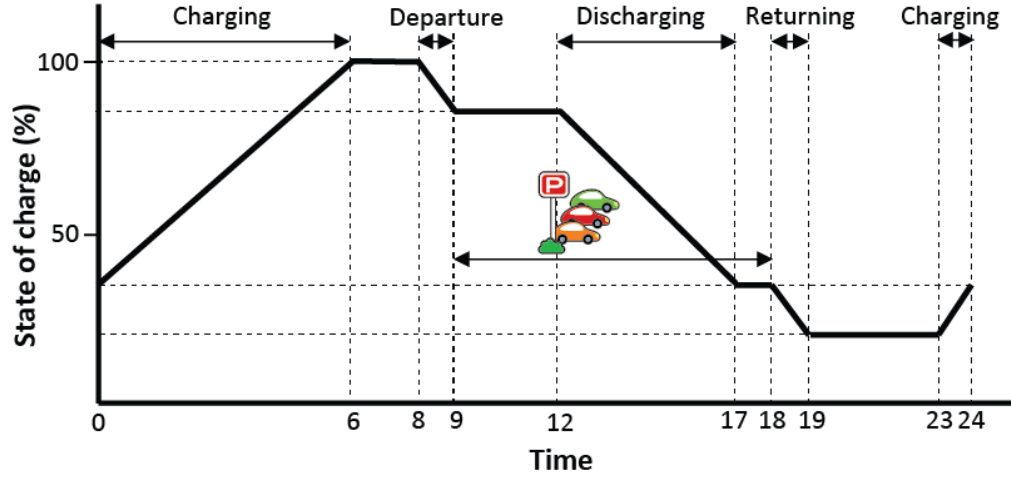
Figure 5. The assumed SOC state of EV for 24 h during a